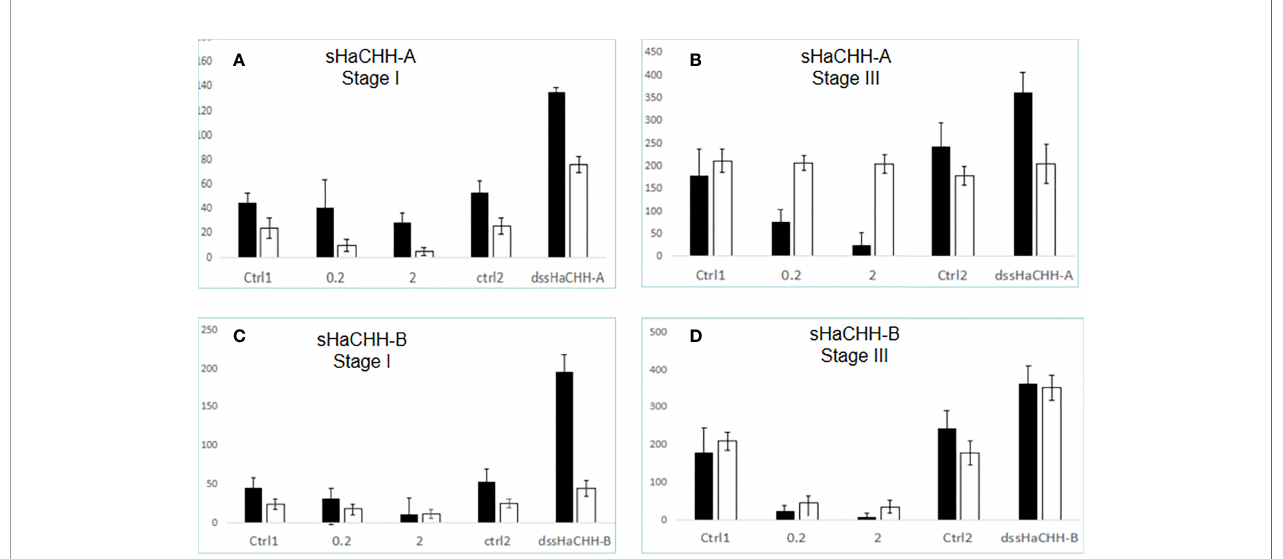
FIGURE 9 | Effect of recombinant proteinand dsRNA for sHaCHH (A, B) and sHaCHH-B (C, D) on HaVg1 gene expression. The Y -axis shows the relative expression level of the HaVg1 gene in the hepatopancreas ( black bar ) and ovary ( open white bar ). Triplicate tests ( N = 4 samples) were performed for each animal. The lobsters used were in the early stage of vitellogenesis (stage I) and middle – late stage (stage III) of the gonad maturation cycle. Tissue fragments were placed inside the well containing 1.5 ml of the nutrient medium M199 with either the control recombinant protein (0, 0.2, or 2.0 m g/PBS) and ctrl2 dsTFV, 2 m g dssHaCHH- A, or dssHaCHH-B. After incubating for 3 h, the hepatopancreas and ovary fragments were analyzed for the expression of HaVg1 . The vitellogenin gene-speci fi c primer was derived from the HaVg1 cDNA, as reported earlier (Tiu et al., 2008). Data are the mean ±